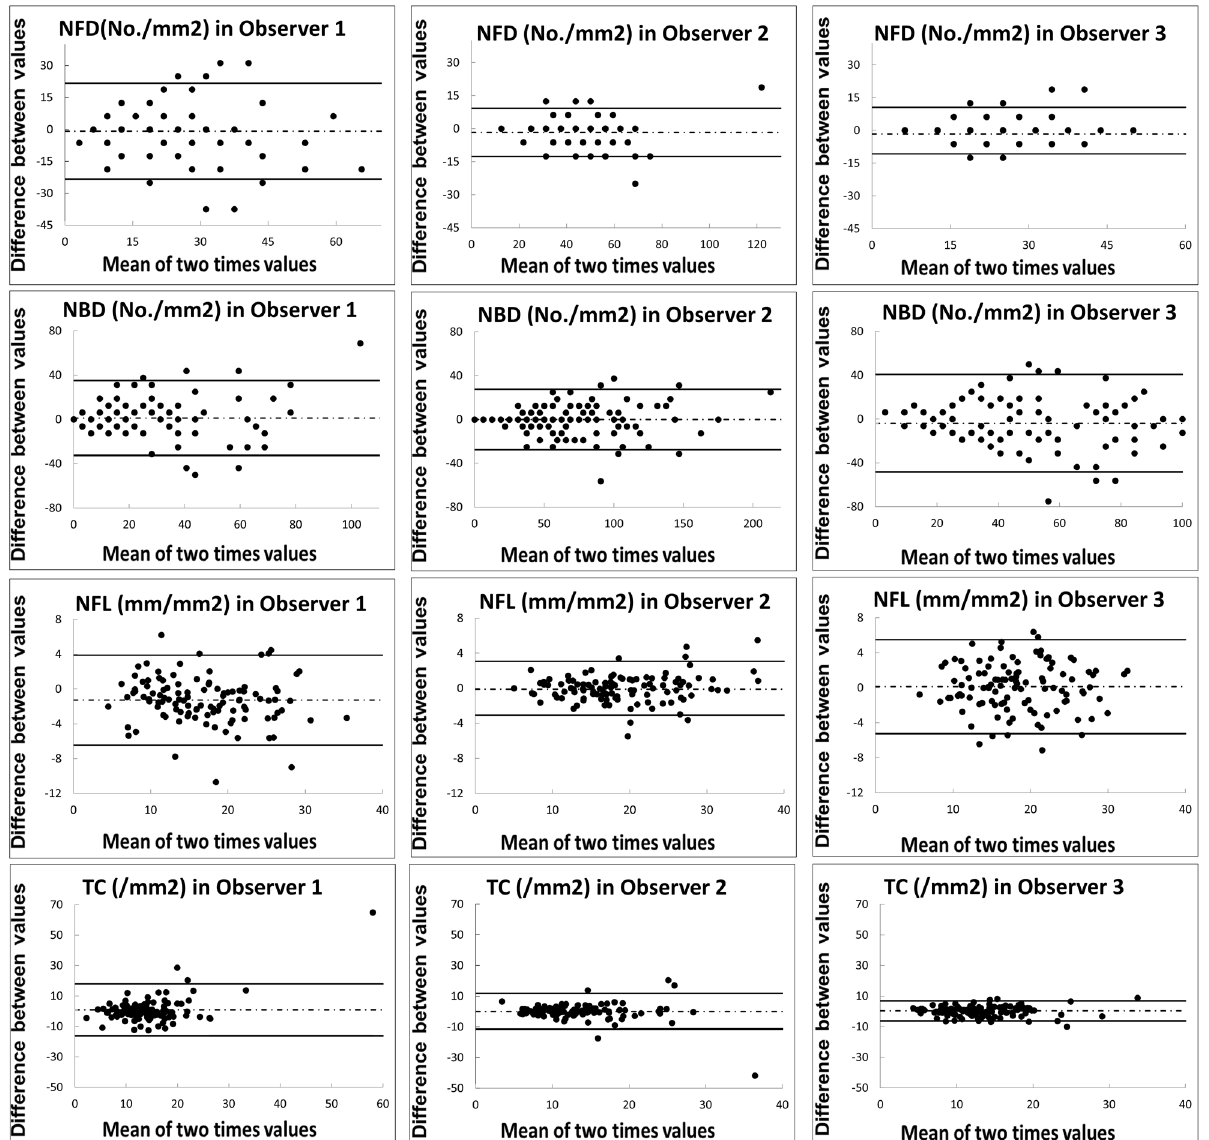
Figure 1. Bland–Altman plots for nerve fiber density (NFD), nerve branch density (NBD), nerve fiber length (NFL), and tortuosity coefficient (TC) to measure intra-observer repeatability in different two evaluations in the original group. The dotted line represents the mean difference, and the solid lines represent the 95% limits of agreement. Observer 2 was found to have the highest repeatability in the original group. In NFL, all three observers reached excellent